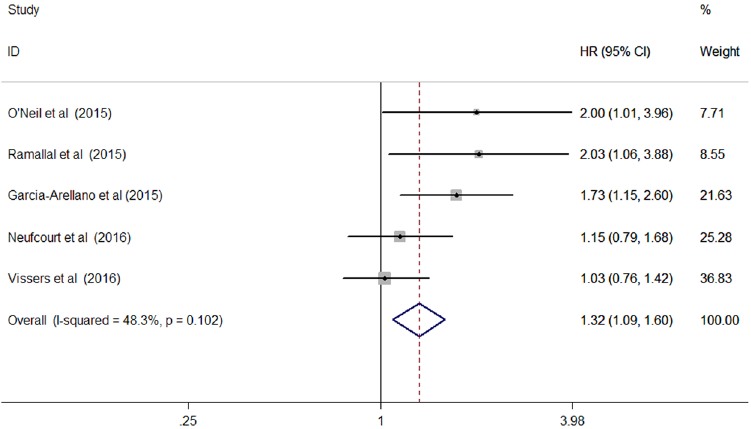
Figure 3. Forest plots showing HR with 95% CI of cardiovascular disease comparing the highest to the lowest dietary inflammatory index